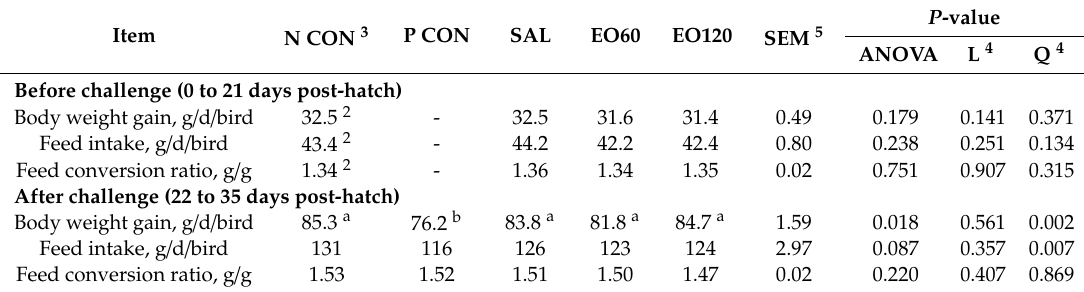
Table 2. E ff ect of dietary encapsulated essential oils on growth performance in coccidiosis-vaccine- challenged broiler chickens 1